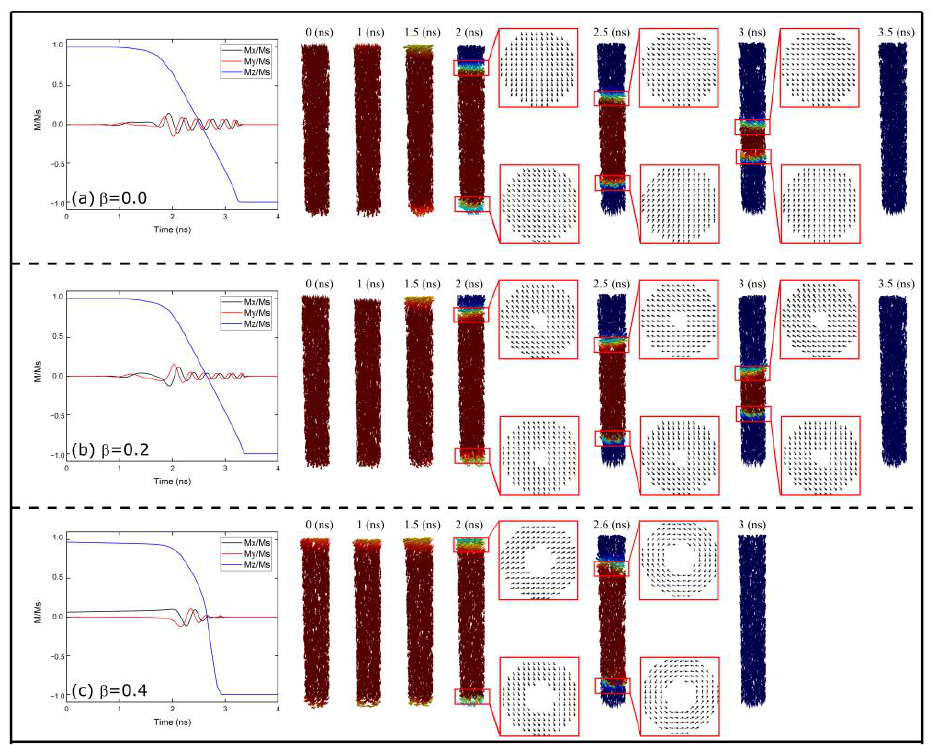
Figure A2. Magnetization reversal of a 1000 nm long Fe 3 O 4 nanotube with an external radius of 30 nm, for β = 0.0 ( a ), 0.2 ( b ), and 0.4 ( c ). The graphs on the left depict the components of magnetization as a function of time, while the snapshots of magnetization at specific times are presented on the right of each graph.